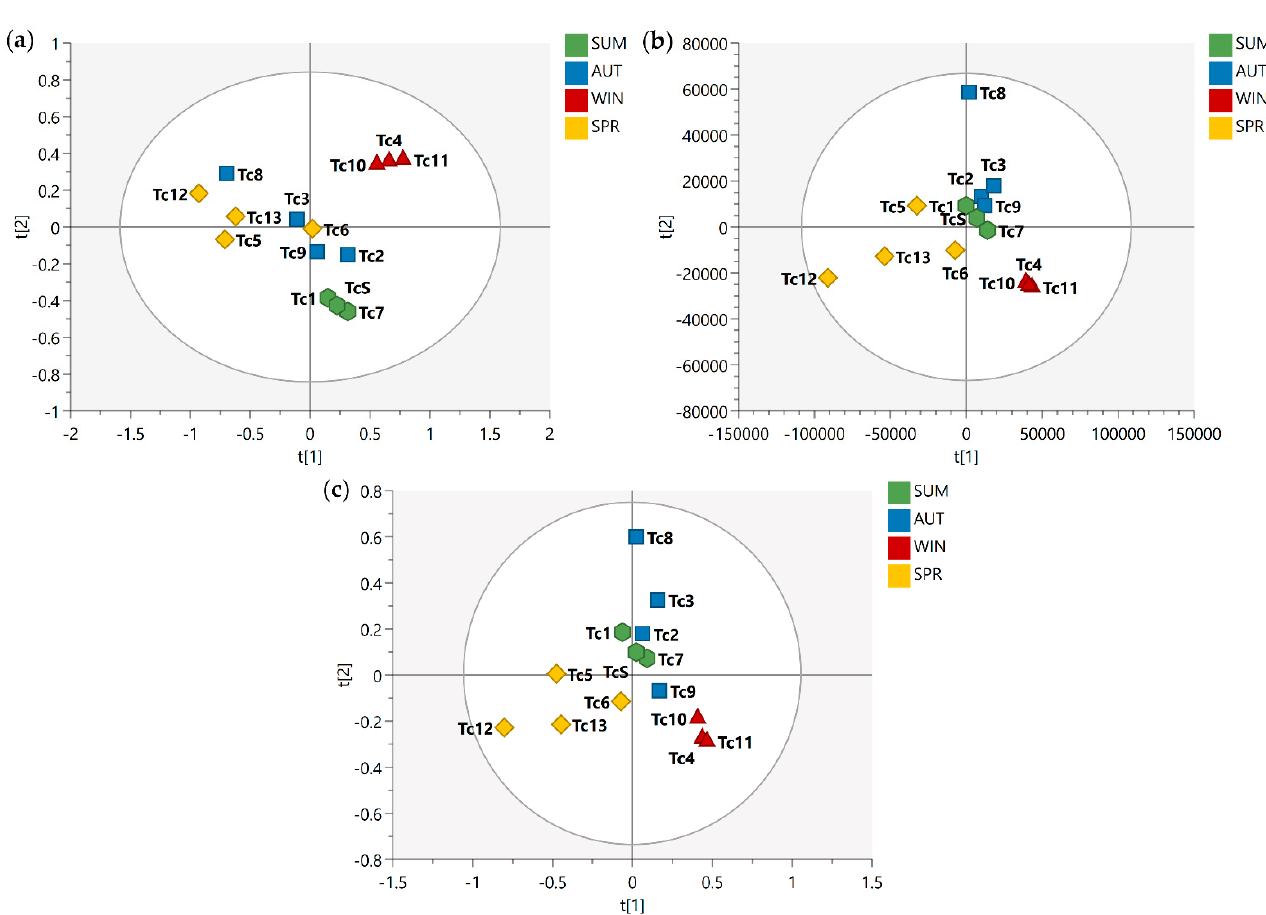
Figure 1. PLS-DA score scatter plots of the T. catappa harvest leaves obtained: ( a ) NMR; ( b ) MS; ( c ) MS-NMR fused analysis for Summer (SUM), Autumn (AUT), Winter (WIN), and Spring (SPR) samples. Season samples are represented by hexagon—SUM (Tc1, Tc7, and TcS), square—AUT (Tc2, Tc3, Tc8, and Tc9), triangle—WIN (Tc4, Tc10, and Tc11), and diamond—SPR (Tc5, Tc6, Tc12, and Tc13).